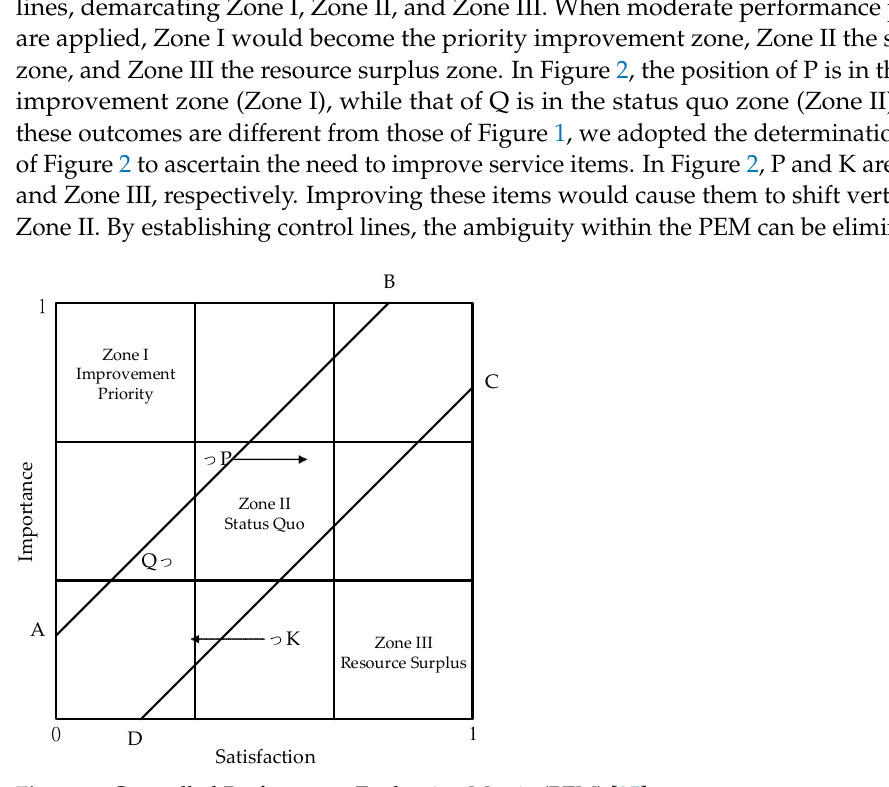
Figure 1. Performance Evaluation Matrix (PEM) [28]. P: status quo zone; Q: improvement zone.